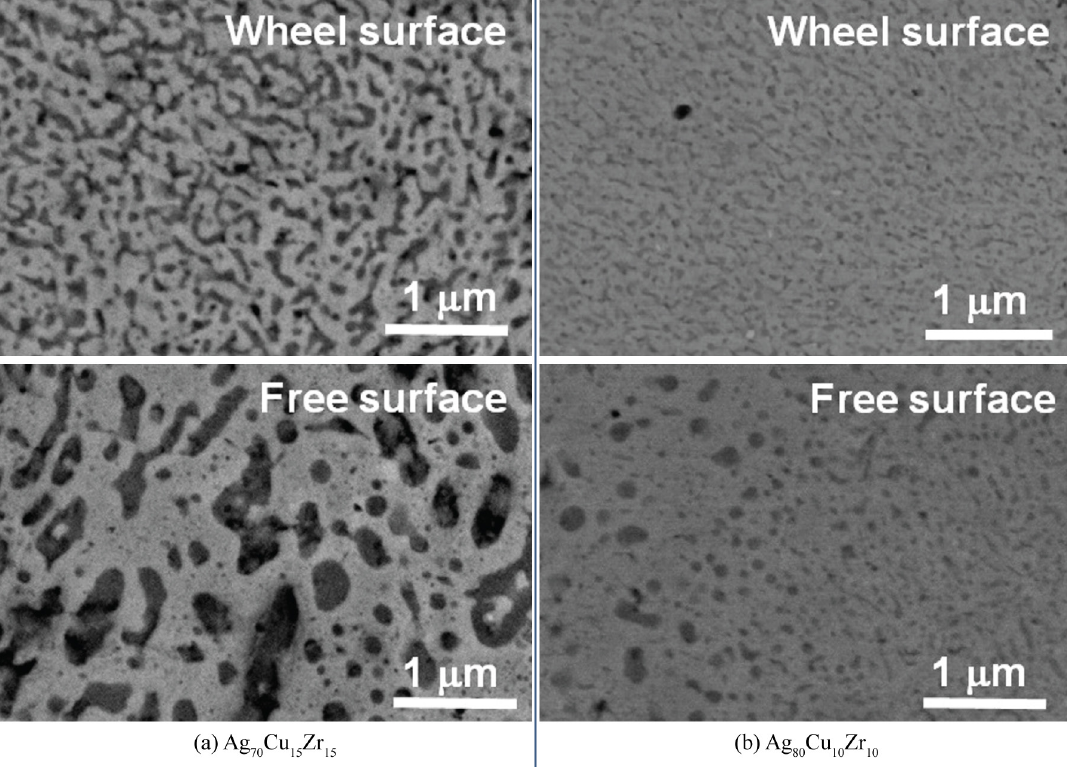
Cu Zr and (b) Ag 70 15 15